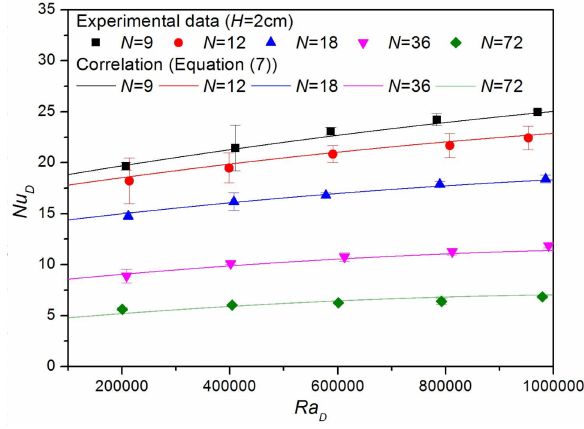
Figure 8. Nusselt numbers for various fin numbers.